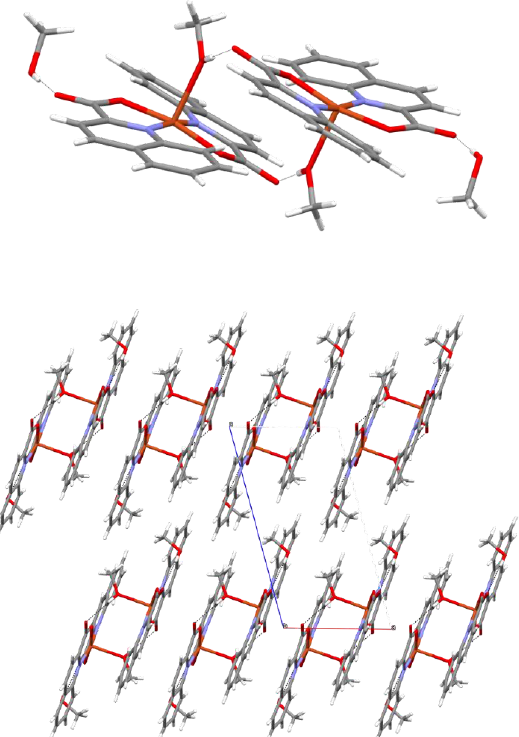
Figure 1. ORTEP drawing of [Cu(quin) 2 (CH 3 OH)], a complex molecule of 1 . Displacement ellipsoids are drawn at the 50% probability level. Hydrogen atoms are shown as spheres of arbitrary radii.